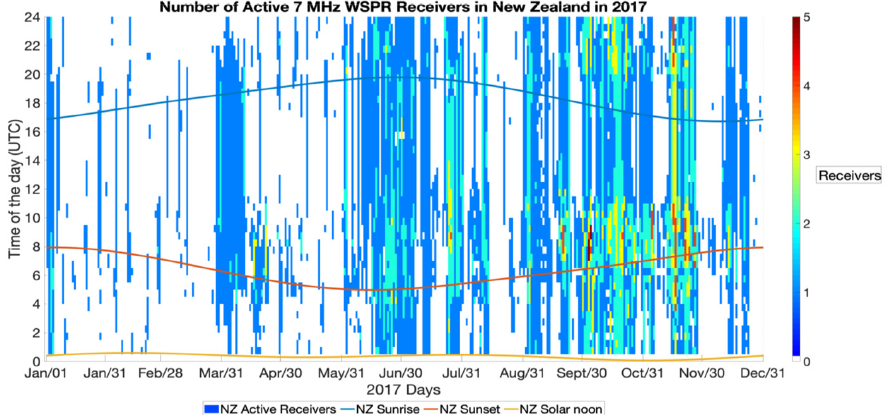
Figure 9. Number of active New Zealand WSPR receivers in 2017. Only receivers with a proven capability to cover the distance from the UK to New Zealand are shown. The colours indicate the number of receivers available in each half-hour interval.